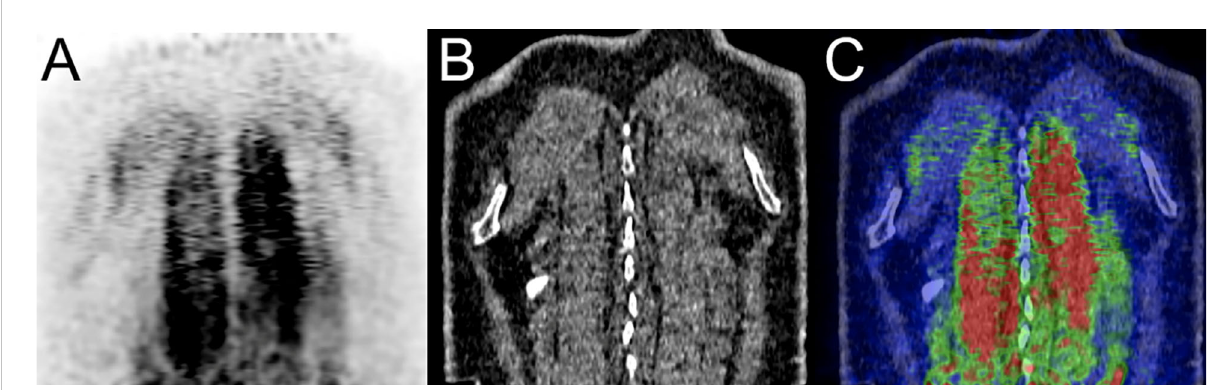
FIGURE 6 Immune-related myositis in a 61-year-old male patient with small cell neuroendocrine carcinoma of the right lung hilum (cT4 cN2 cM0, stage IIIB) initially treated with chemo-radiation therapy who developed diffuse metastatic disease. A treatment with ipilimumab (anti-CTLA-4) and nivolumab (anti-PD-1) was administered. At 1-month post-immunotherapy, a 68 Ga-DOTATOC-PET/CT showed diffuse myositis of paraspinal muscles coronal PET, CT and fused PET/CT images (A – C) respectively showing spinalis, longissimus thoracis and iliocostalis thoracis